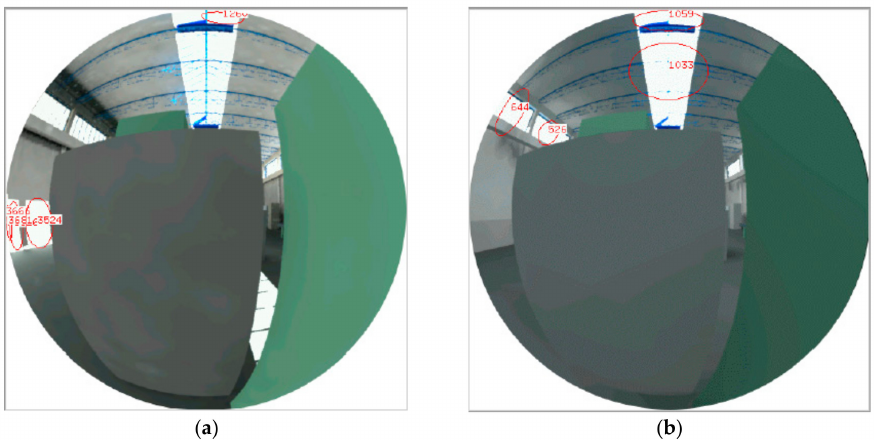
Figure 10. Result of simulated glare sources at the workplace for sunny sky conditions: ( a ) wire skylight glazing; ( b ) di ff use skylight